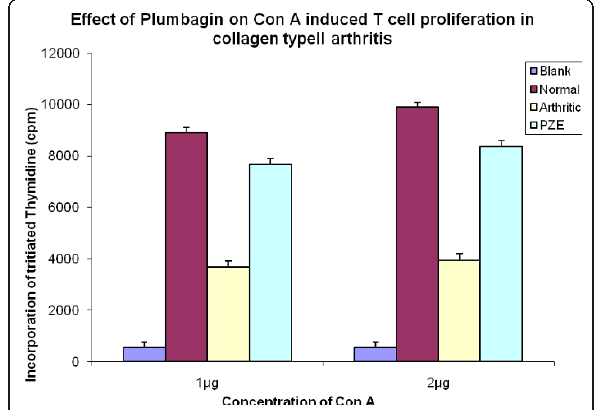
Figure 4 Effect of Plumbagin on Con A induced T cell proliferation in collagen Type II induced arthritis . Two groups of DBA/1 mice immunized with 0.1 ml of bovine type II collagen intradermally at the base of the tail. Booster dose was given on day 21. Normal group did not receive any injection. Test group was treated intraperitoneally with Plumbagin. Control group was treated with vehicle alone. At the end of the experiment mice were sacrificed, and Spleenic T lymphocytes isolated from arthritic mice,